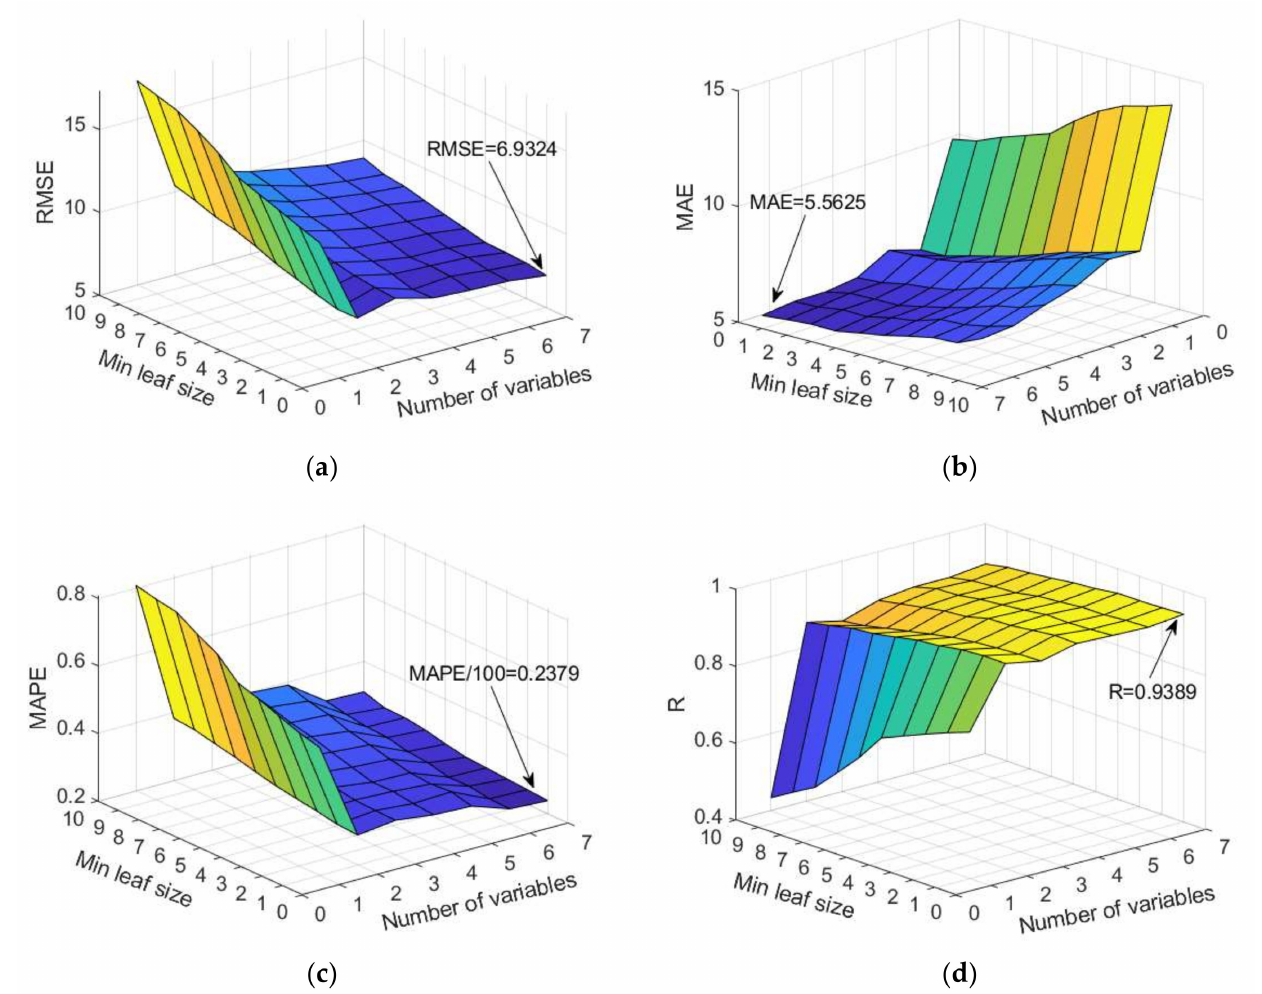
Figure 14. Comparison of different accuracy criteria for RF model as a function of the number of randomly selected splitting variables and minimum leaf size: ( a ) RMSE, ( b ) MAE, ( c ) MAPE, and ( d )